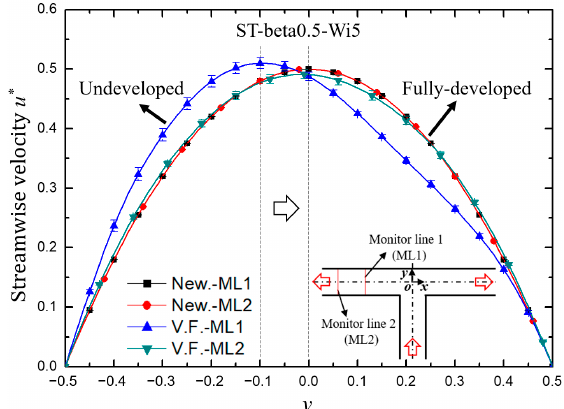
Figure 4. The variation of ( a ) streamwise velocity and ( b ) pressure with dimensionless time. In the legend, the symbols of MP1 and MP2 describe the monitor points of ( x , y ) = ( − 5, 0) and ( x , y ) = ( − 10, 0), respectively. The symbols of New. and V.F. denote respectively Newtonian and viscoelastic fluid. For both cases, Re = 0.01. For viscoelastic fluid, Wi = 5, β = 0.5.